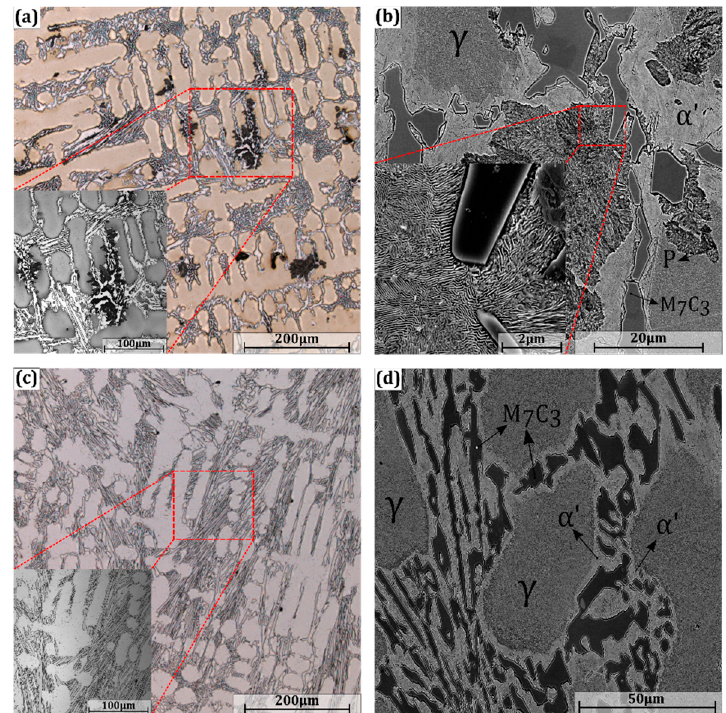
Figure 1. Representative OM (200 × ) and SEM micrographs of samples A ( a , b ) and B ( c , d ), respectively, after Vilella’s etching. Inset in ( a , c ) represents a magnified image (500 × ) acquired using laser light. The different phases, austenite ( γ ), martensite ( α ’), pearlite (P), and eutectic carbides (M 7 C 3 ) are indicated in images ( b ) and ( d ). The pearlite phase can be observed in the inset in ( b ).